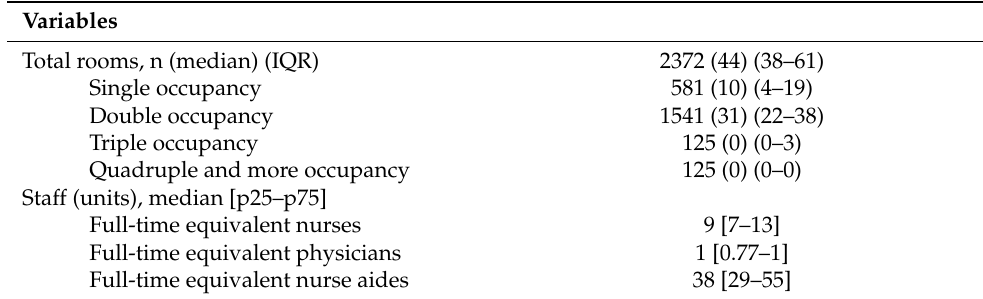
Table A2. Additional information on characteristics of the nursing homes retrieved by means of the infection prevention and control survey (N = 45).